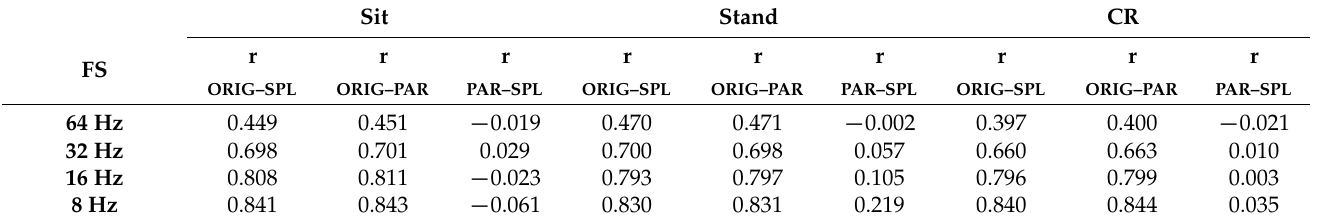
Figure 5. Boxplots of the beat-to-beat AEs computed with the original IBIs and with those obtained through SPLINE and PARABOLA interpolations. Significant differences (Bonferroni-corrected comparisons, p < 0.05) are highlighted between AEs within each sampling frequency and protocol condition. a: AEs related to SPLINE (S) or PARABOLA (P) are significantly different from the orig- inal; b: AEs related to SPLINE (S) are significantly different from PARABOLA.